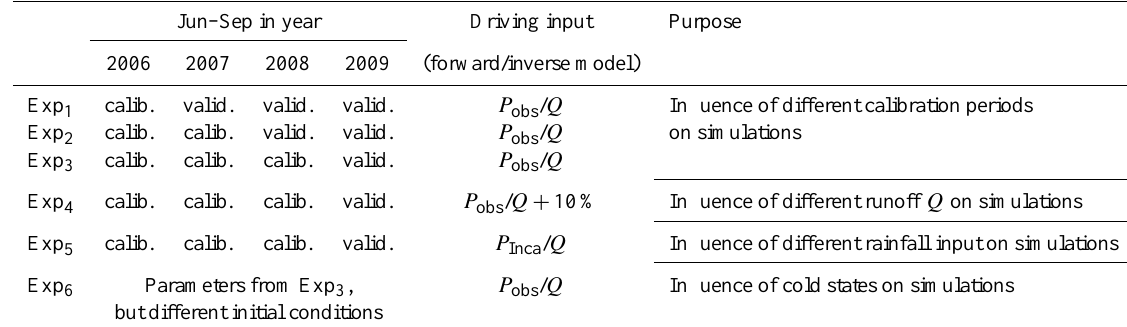
Table 5. Overview of the model calibration and simulations experiments with observed input data. P obs and P Inca refer to the rainfall from the station observations and the INCA system.